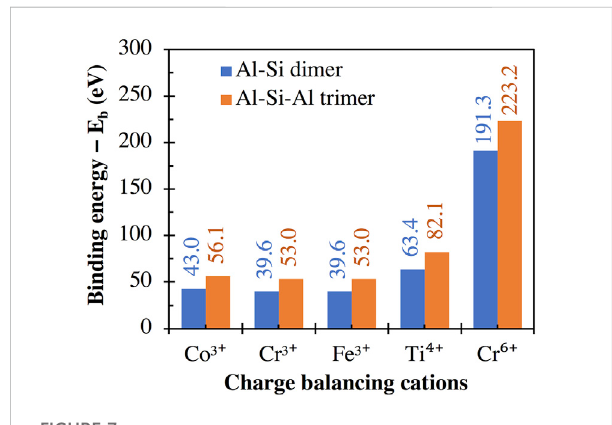
FIGURE 7 Binding energies between (i) the aluminosilicate dimer (i.e., [(OH) 3 -Si-O-Al-(OH) 3 ] − 1 ) and trimer (i.e., [(OH) 3 -Al-O-(OH) 2 -Si- O-Al-(OH) 3 ] − 2 ) and (ii) different high valent cations, calculated using Eq. 1, with the total energies of individual components in Eq. 1 given in Supplementary Table S1.